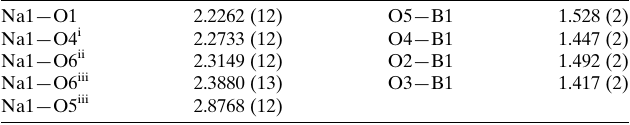
Table 2 Experimental details.